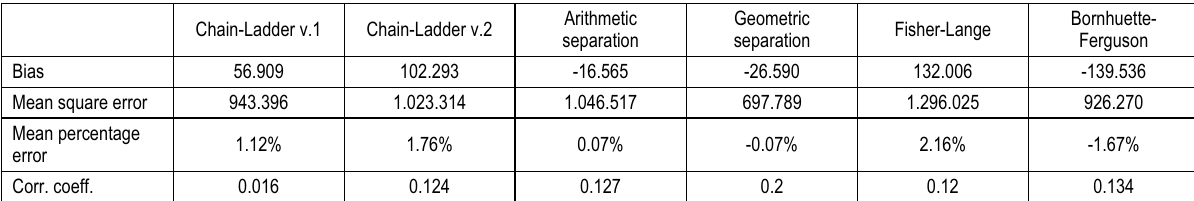
Table 13. Pentikainen-Rantala method